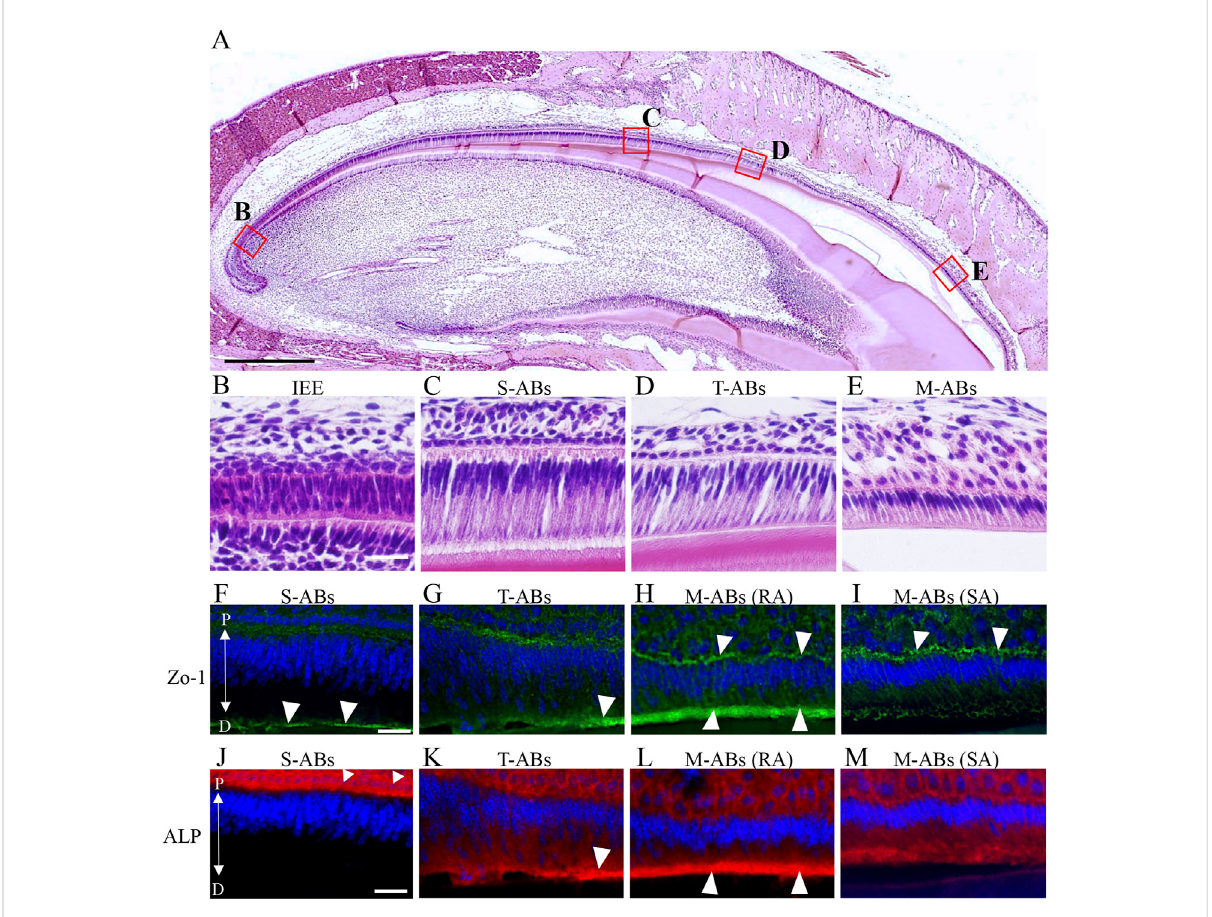
FIGURE 1 Differential expression of Zo-1 and ALP during amelogenesis in the maxillary incisor. (A) Low magni fi cation image of H&E-stained sections of mouse maxillary incisors. The boxed areas in (A) are magni fi ed in (B – E) . (B) Inner enamel epithelium cells. (C) Secretory stage ameloblasts. (D) Transitionstageameloblasts (E) Maturationstageameloblasts. (F – I) Zo-1immunostainingofmousemaxillaryincisorameloblasts. (J – M) ALPstaining of mouse maxillary incisor ameloblasts. The nucleus is stained with DAPI (blue). S-ABs, secretory stage ameloblasts; T-ABs, transition stage ameloblasts; M-ABs, maturation stage ameloblasts; RA, ruf fl e-ended ameloblasts; SA, smooth-ended ameloblasts; P, proximal; D, distal. Scale bars: 500 μ m (A) ; 20 μ m (B – M)